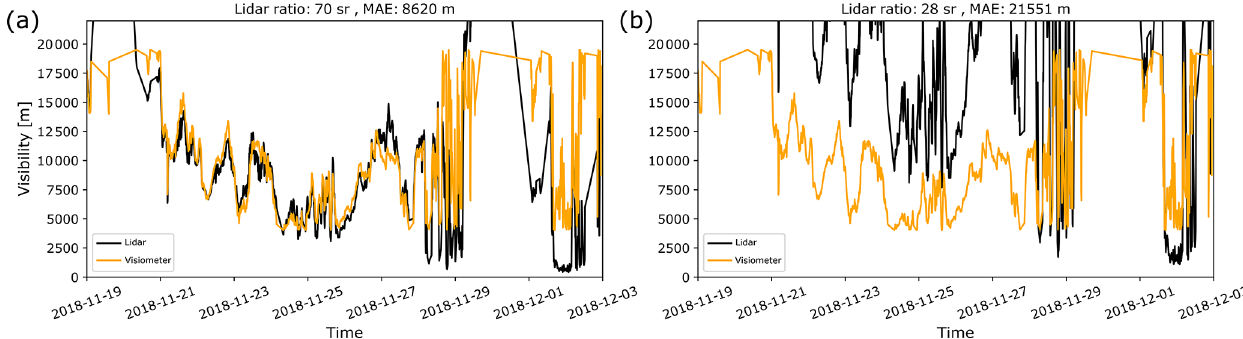
Figure 4. Linking lidar backscatter from 39ma.g.l. to visibility for Cabauw using method A. (a) Lidar ratio is 70sr (continental). (b) Lidar ratio is 28sr (marine), and the Ångström exponent is 2.0 for both. The visibility sensor data are from 40ma.g.l.